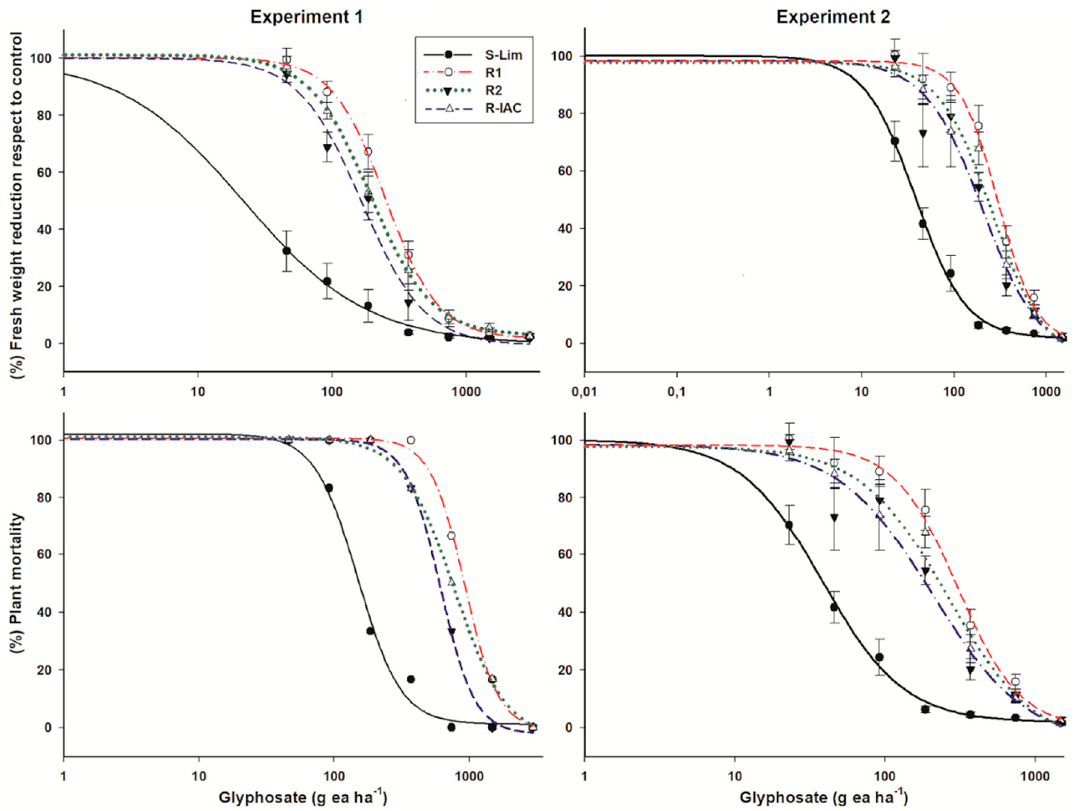
Figure 1. Glyphosate dose-response curves relative to percentages of fresh weight reduction and plant survival of susceptible and resistant slender amaranth ( Amaranthus viridis L.) populations collected in citrus orchards from São Paulo State, Brazil. Vertical bars of the fresh weight reduction plots represent the standard error of the mean ( n = 6).